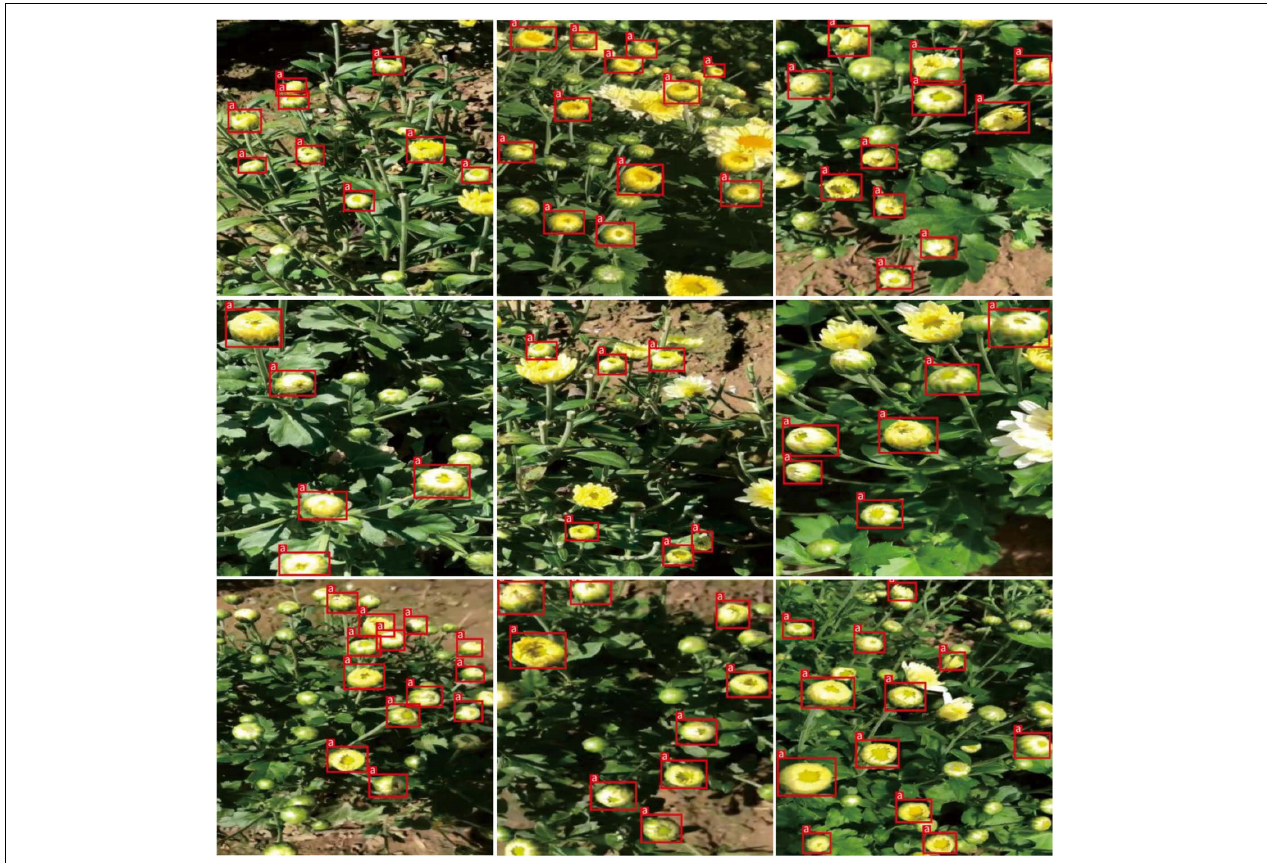
FIGURE 6 | Qualitative results of our method. The red box indicates the recognised tea chrysanthemum.